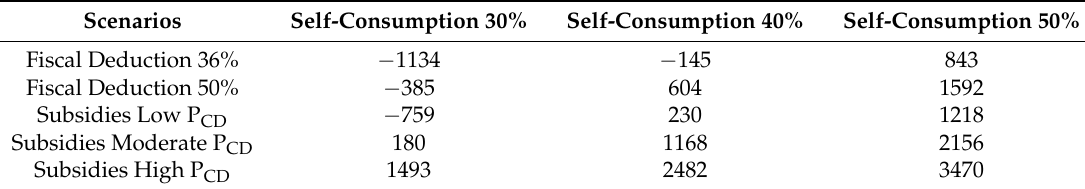
Table 8. NPV in alternative scenario (C inv,unit = 2100 € /kW). Data expressed in € .